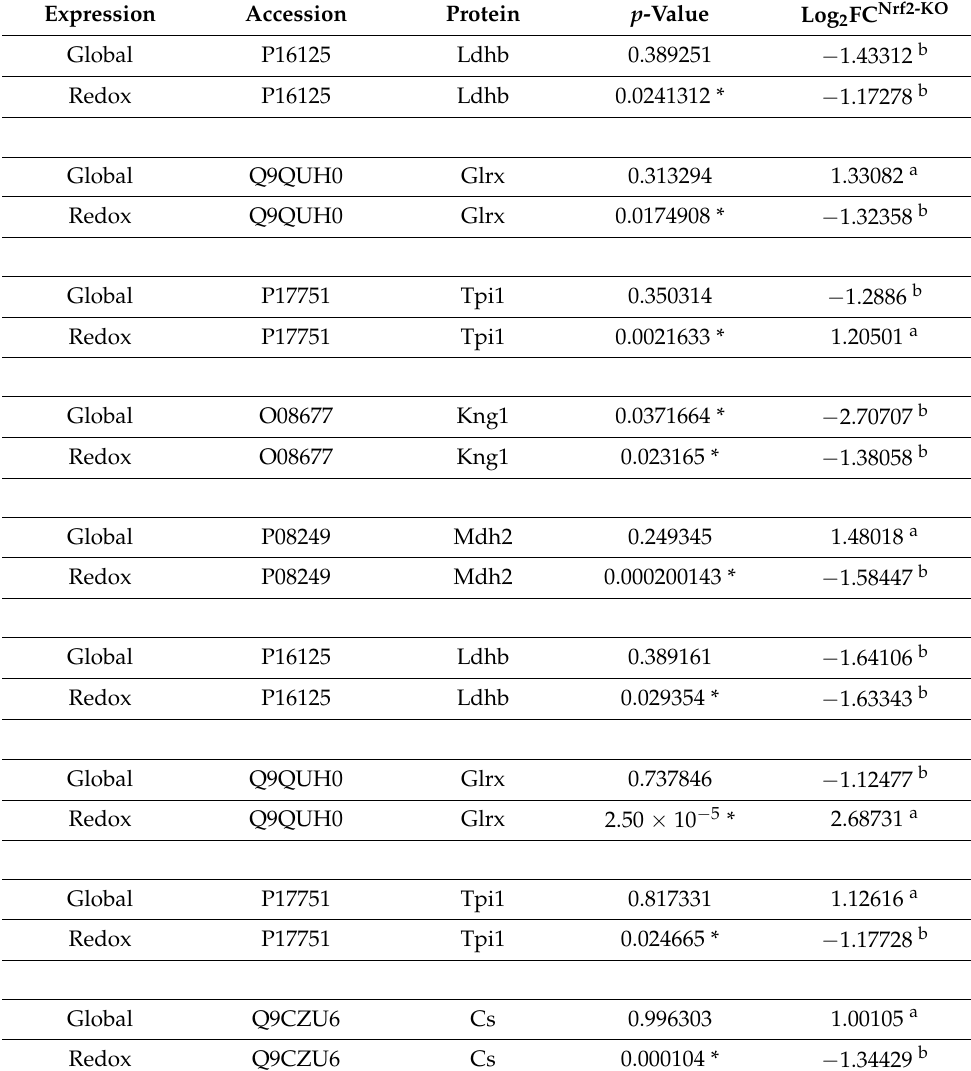
Table 5. List of differentially expressed redox peptides in Nrf2/Keap1-KO-deficient muscle and corresponding global protein expression